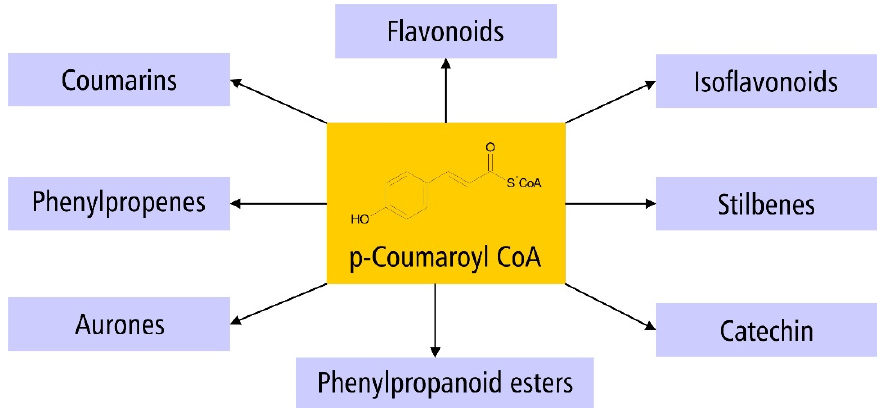
Figure 3. Compounds generated from p -Coumaroyl CoA in the phenylpropanoid pathway [81].